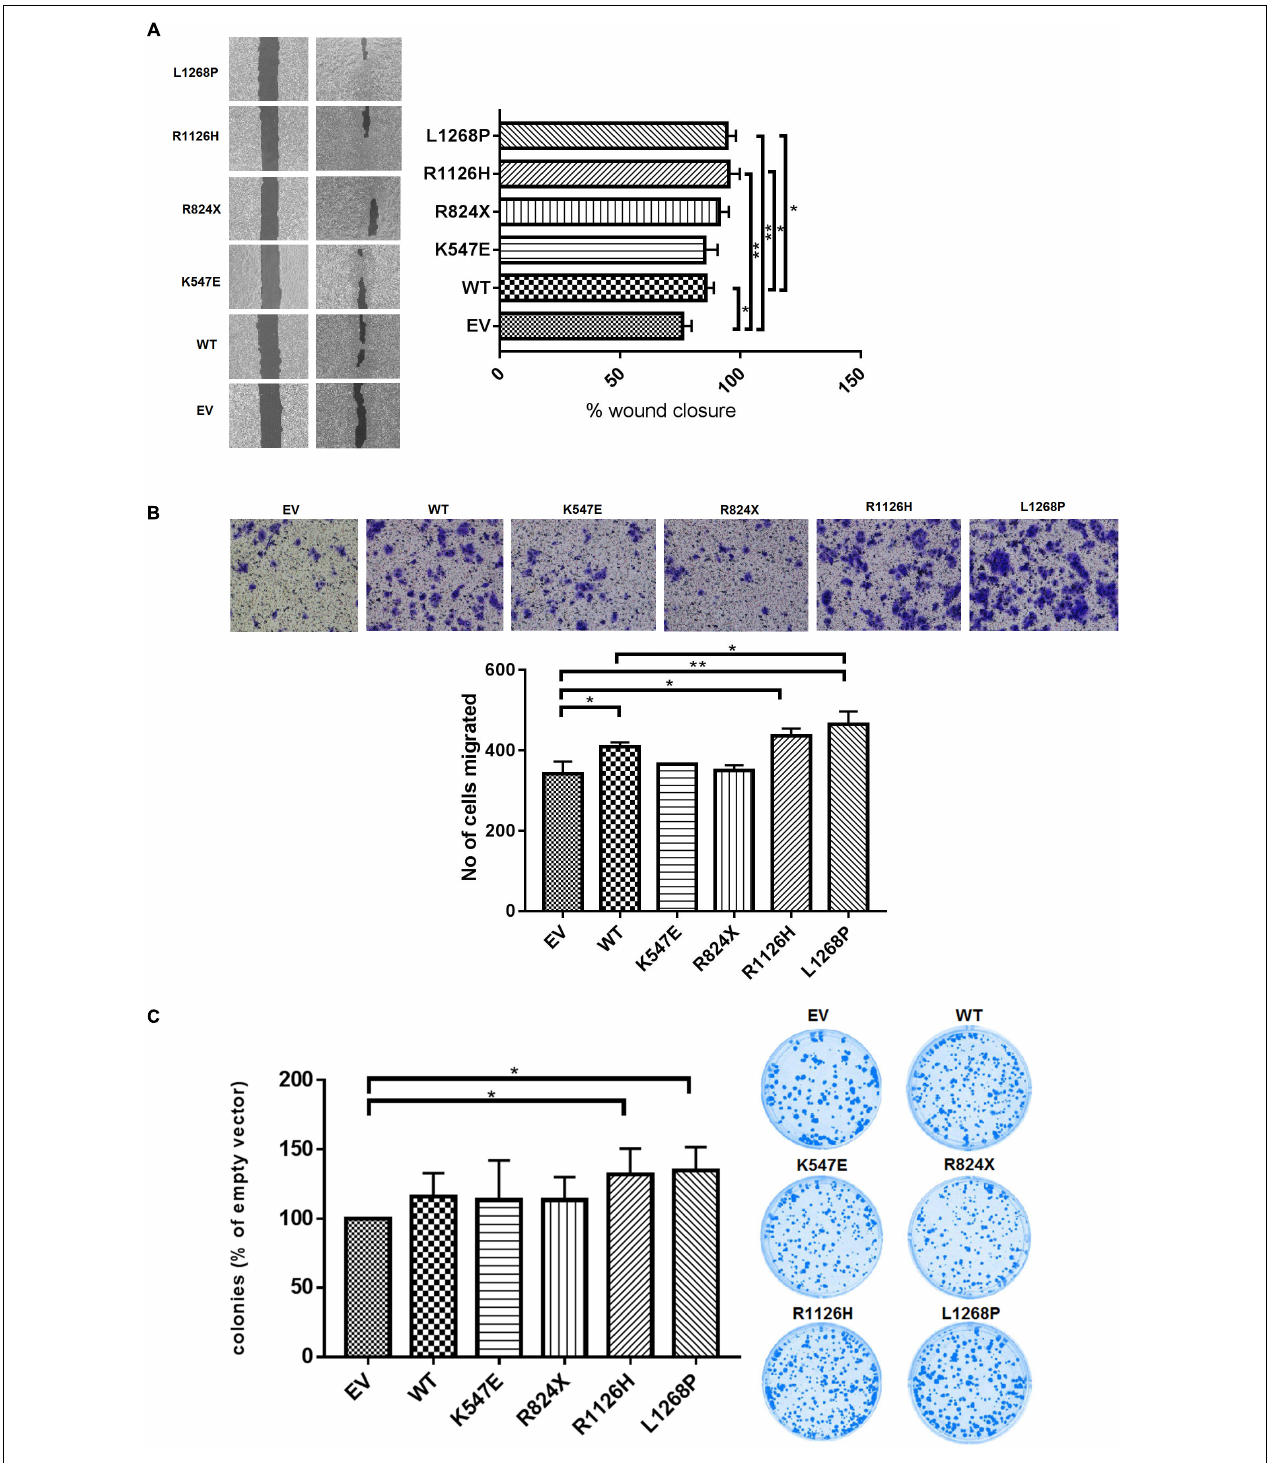
FIGURE 4 | Effect of WHSC1 mutants on cell migration and clonogenic potential. (A) Wound healing assay displayed significant increase in average rate of wound closure at 72 h shown in R1126H and L1268P compared with EV and WT. (B) Transwell migration assay showed the numbers of migrated mutants R1126H and L1268P were significantly higher than EV. (C) Clonogenic survival was assessed by colony formation assay at day 14. The numbers of colonies were counted after crystal violet staining, and are expressed as percentage of cells expressing empty vector. There is significance of colony formation in R1126H and L1268P when compared with empty vector. No obvious effects were observed on the colony formation ability of EEC-1 cells after transfection with WT and mutants K547E and R824X. Statistical significance was measured by Student’s t -test ( ∗ p < 0.05), n = 3. Error bars represent average ± SD.